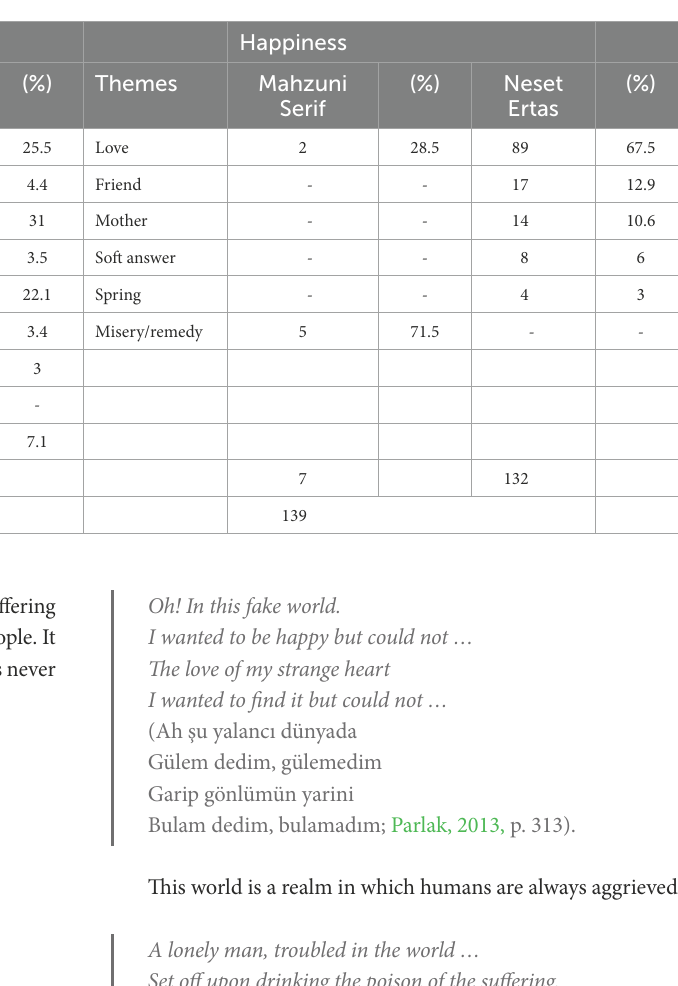
TABLE 1 Suffering and happiness in the Turkish folk